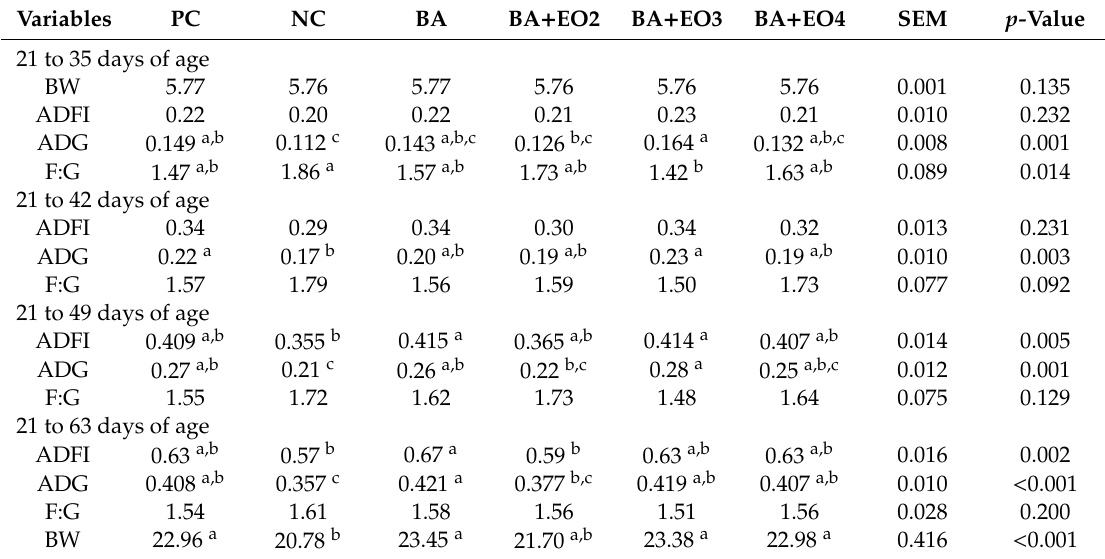
Table 2. E ff ect of experimental diets on the performance of piglets challenged with E. coli